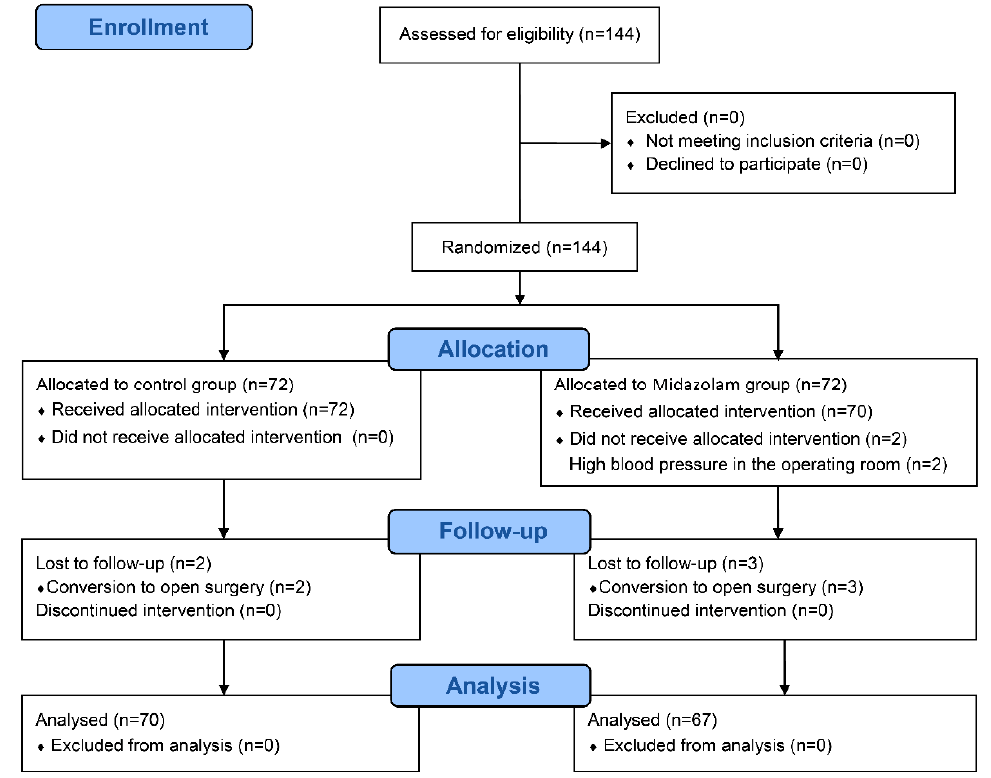
Figure 1. CONSORT flow diagram.